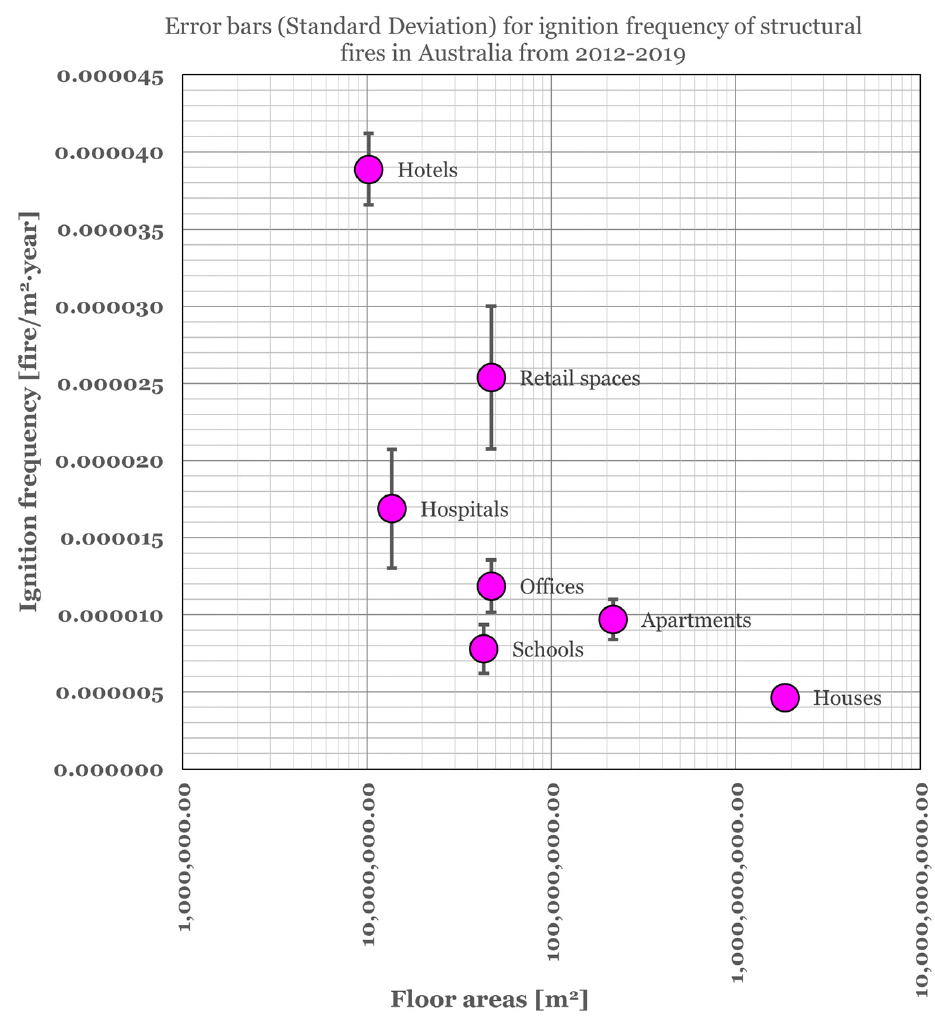
Figure 10. Error bar graphs from the historical data series for ignition frequency of structural fires in Australia from 2012 to 2019.